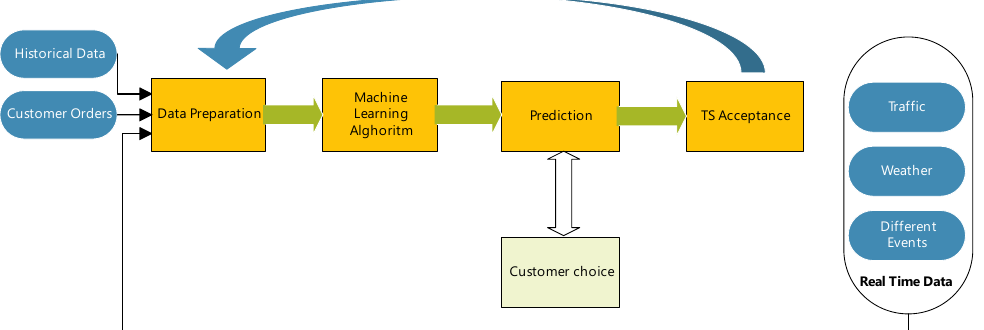
Figure 3. Sustainable AHD Framework Prediction structure.